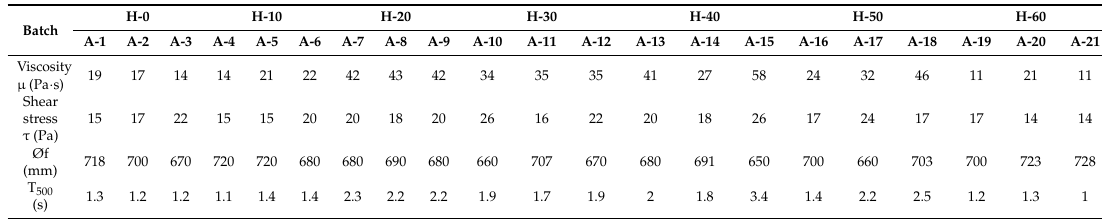
Figure 3. 4C-Rheometer. Table 2. Rheological data.